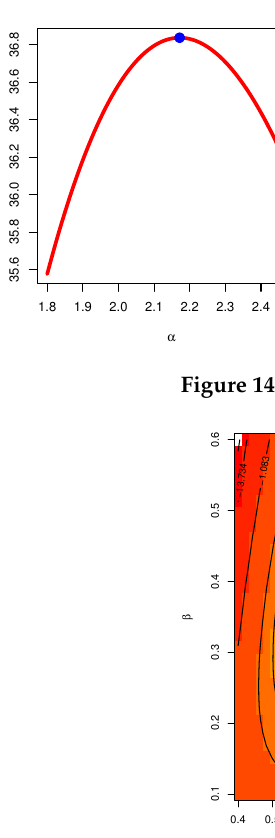
Figure 13. Estimated pdf, CDF, and P-P plots of UEPD for failure of 20 components data.